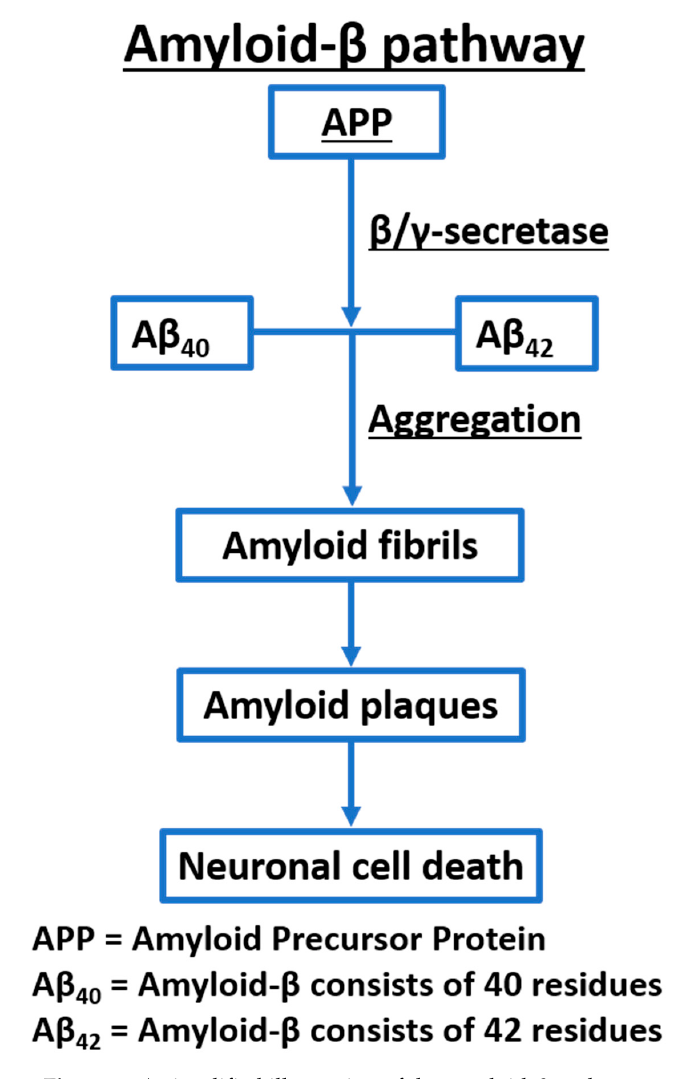
Figure 1. A simplified illustration of the amyloid- β pathway.